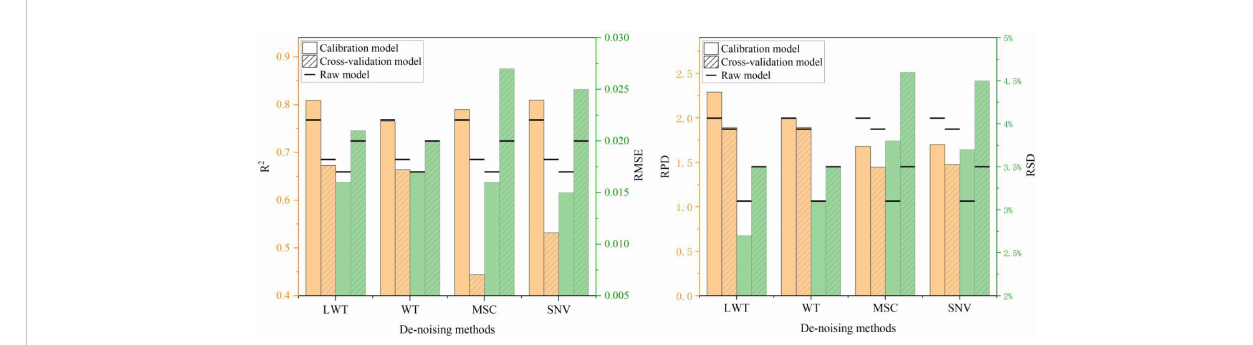
FIGURE 6 The comparison analysis of various de-noising methods for Chinese white poplar